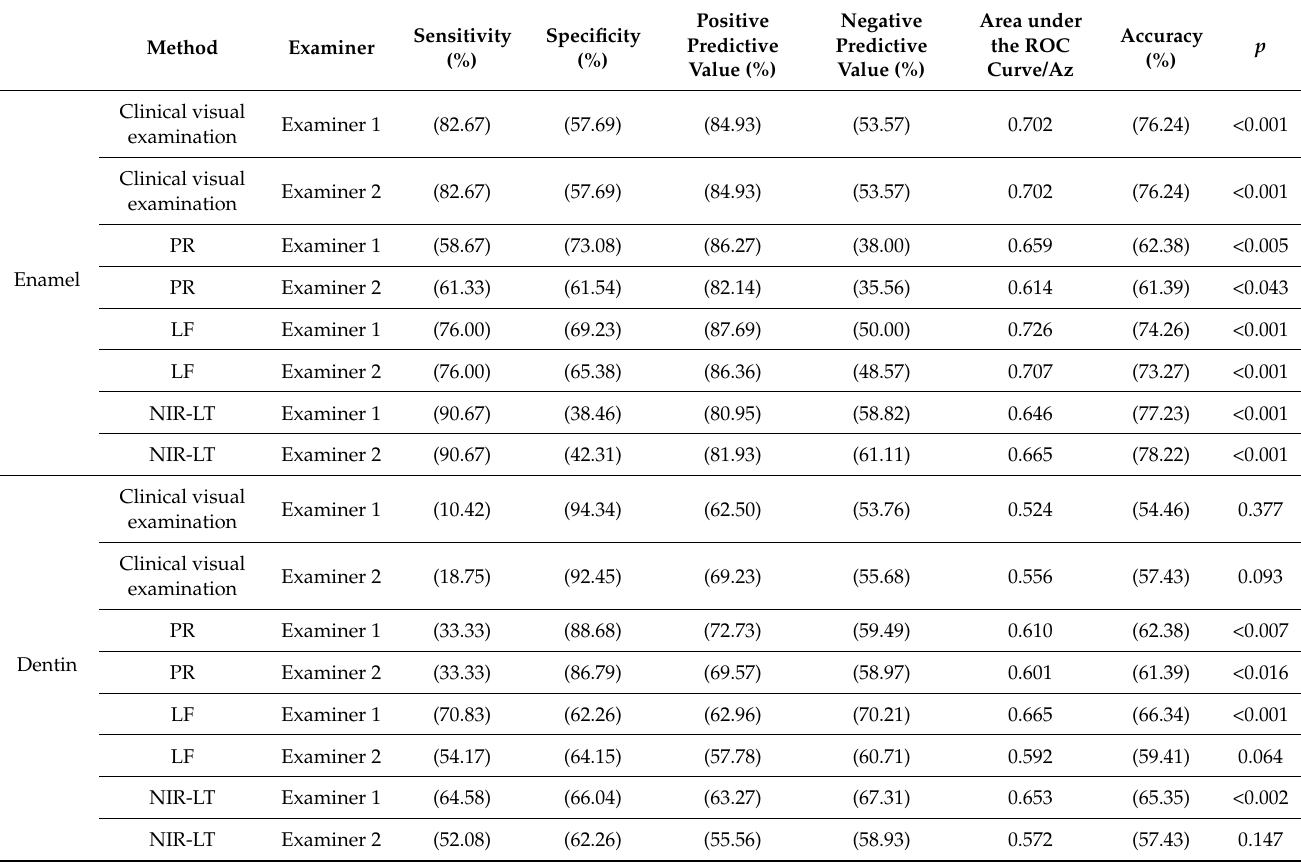
Table 1. Sensitivity, specificity, positive predictive value, negative predictive value and accuracy of clinical visual examination, periapical radiography (PR), laser fluorescence (LF) and near-infrared light transillumination (NIR-LT) in comparison to micro-CT at the enamel and dentin thresholds.